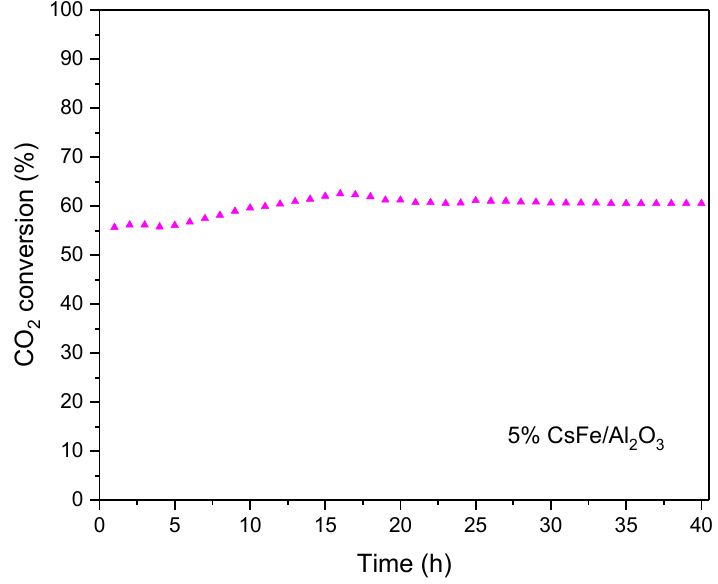
◦ C, WHSV of 12,000 mL/g